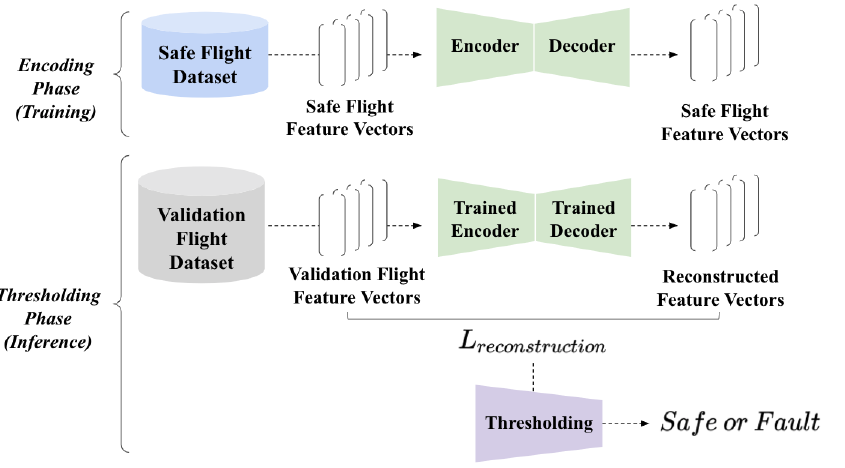
Figure 1. The overall structure of the proposed fault detection model. During the encoding phase, we acquired safe flight logs and extracted feature vectors from the logs, and trained the autoencoder to scrutinize safe flight patterns. During the thresholding phase, our approach takes a validation feature vector that is acquired from the validation flight logs, provides the input to the autoencoder, and acquires the reconstruction loss. If the reconstruction loss is larger than the particular threshold, then our approach identifies the Unmanned Aerial Vehicle’s (UAV’s)